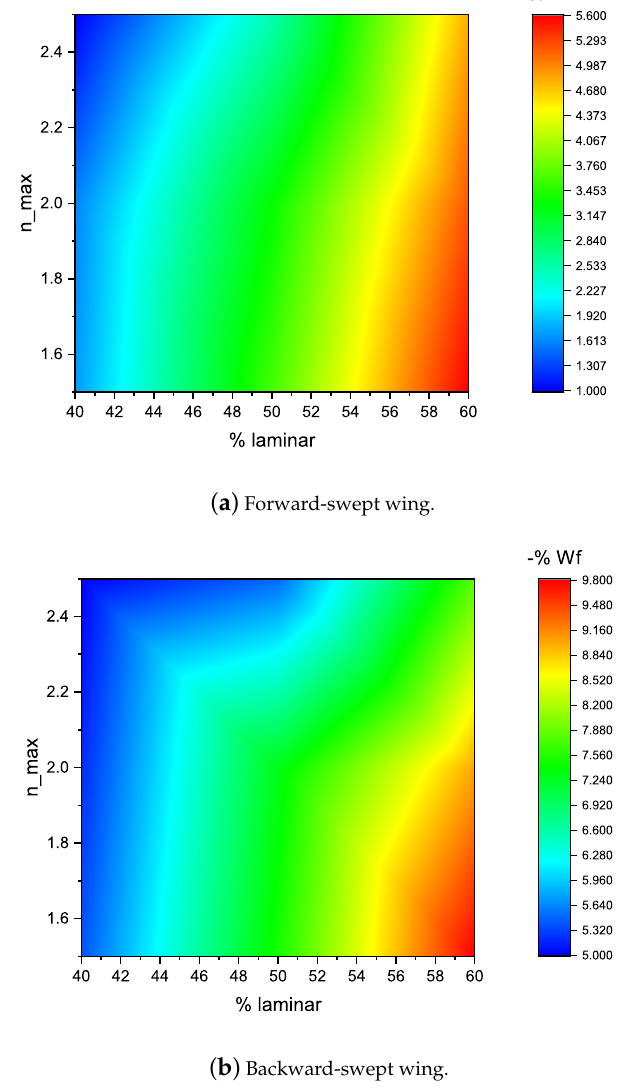
Figure 13. SE 2 A midrange W f